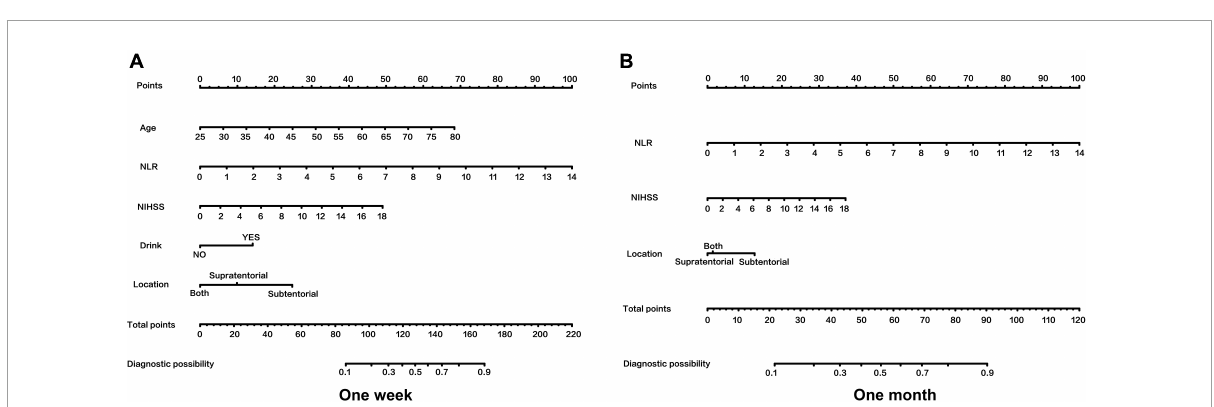
FIGURE2 (A,B) The nomograms for predicting the prognosis of AIS patients. NIHSS, National Institutes of Health Stroke Scale on admission; NLR, Neutrophil to lymphocyte ratio. To use the nomogram, an individual patient’s value is located on each variable axis, and a line is drawn upward to determine the number of points received for each variable value. The sum of these numbers is located on the Total Points axis, and a line is drawn downward to the probability axis to determine the likelihood of